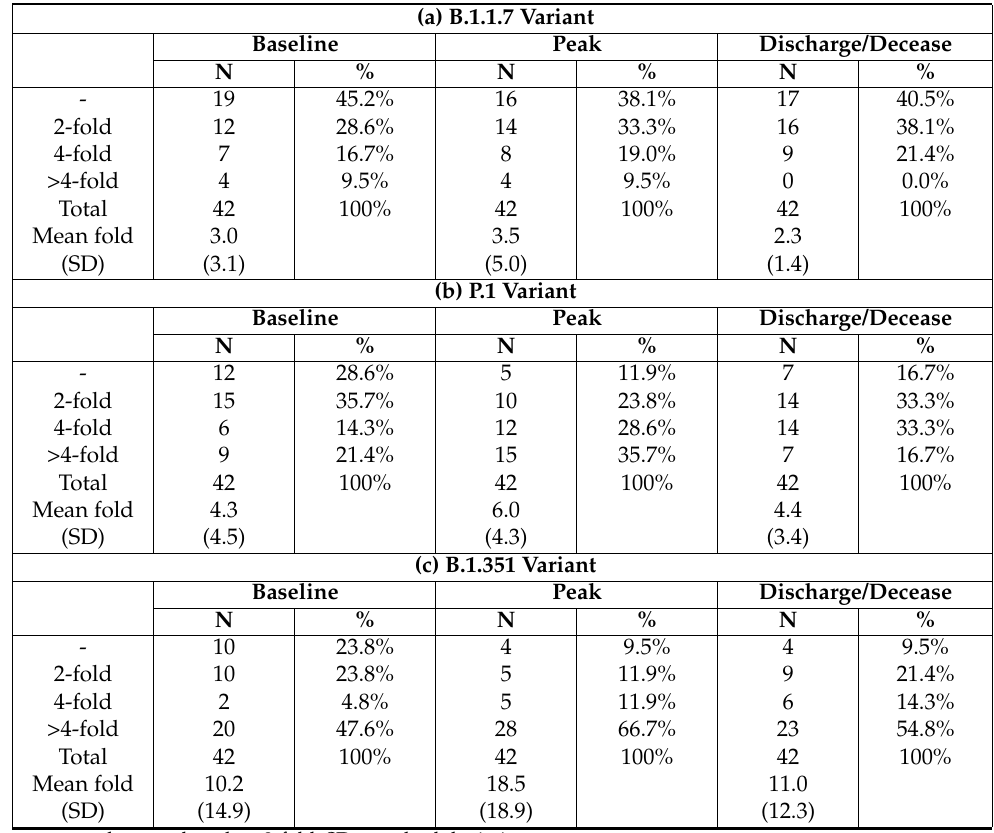
Table 1. Fold decrease in neutralizing antibody titers of B.1.1.7 (a), P.1 (b) and B.1.351 (c) variants with respect to the wt strain by time point (baseline, peak, and